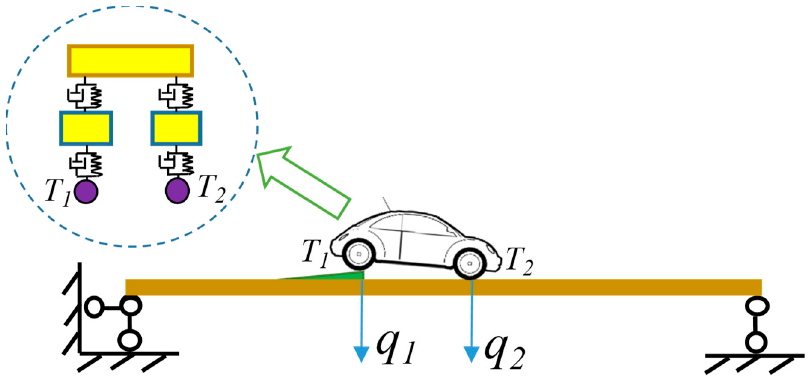
Figure 3. Diagram of vehicle bump on a bridge using a 4-DOF vehicle model.